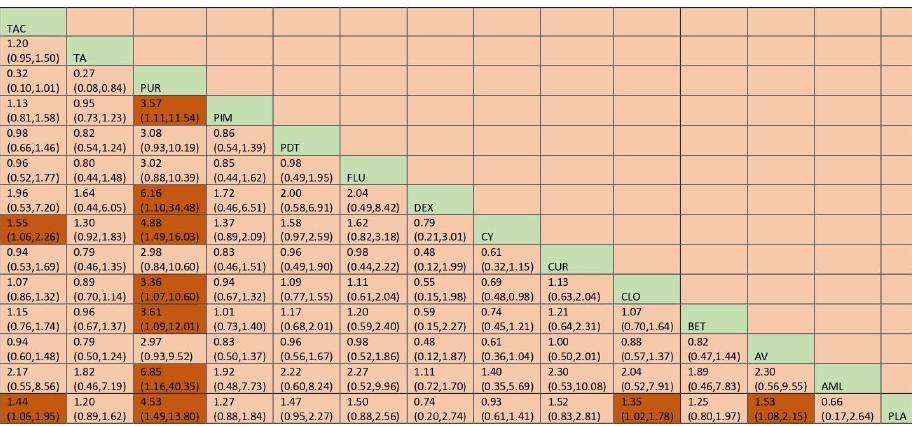
Figure 15. League table for clinical Improvement (subgroup analysis). Abbreviations: AML, amlexanox paste; AV, aloe vera; CUR, curcumin gel; PDT, photodynamic therapy; PLA, placebo; PUR,